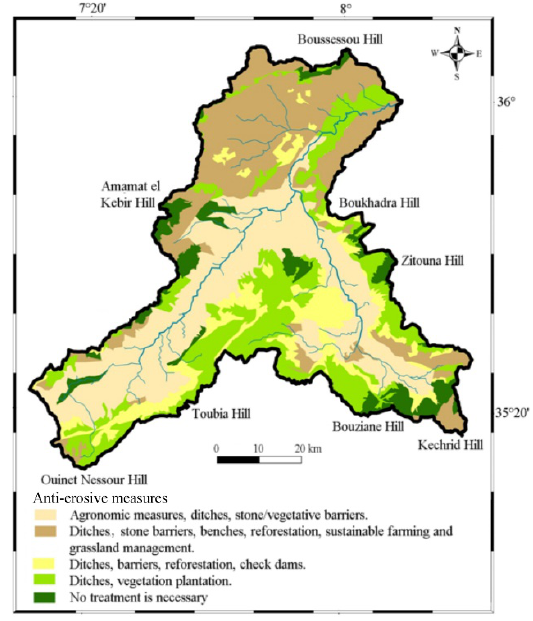
Areas of potential sensitivity to erosion at Mellegue catchment and its sub-basins